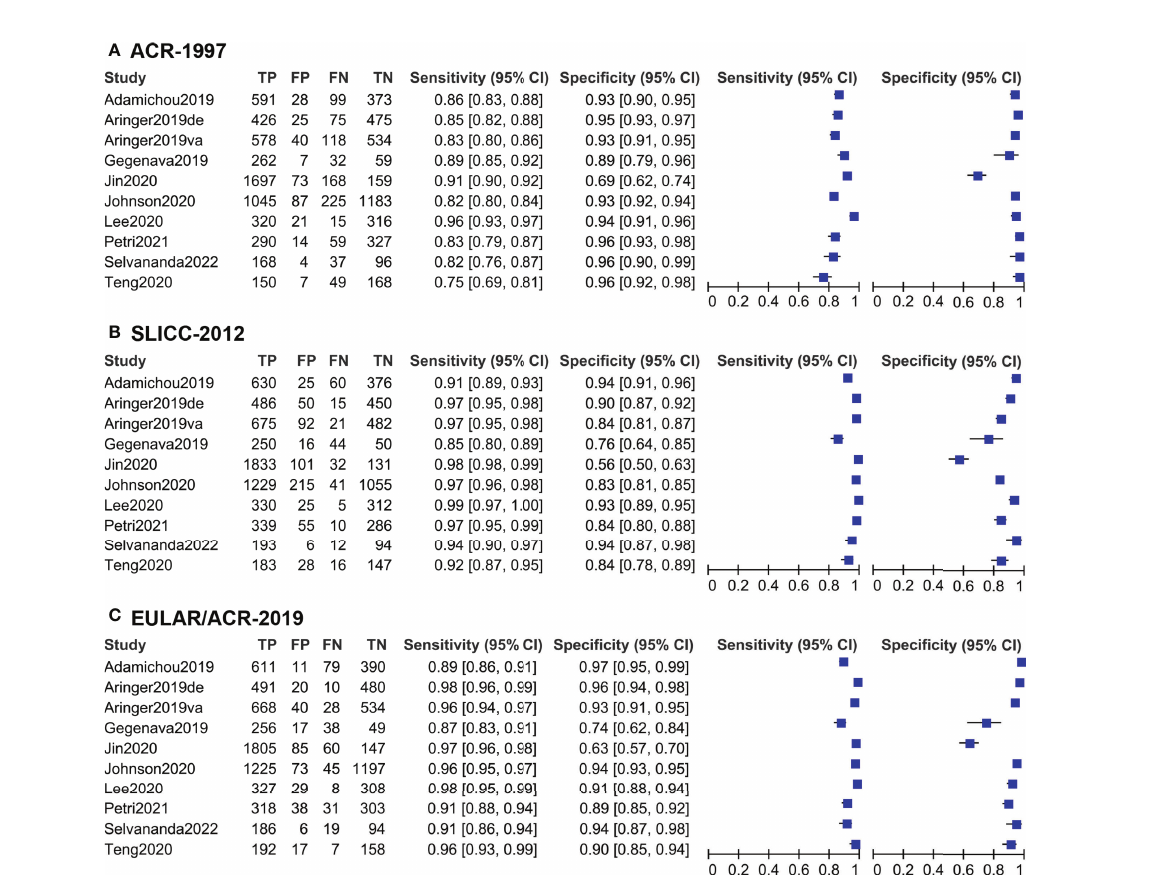
FIGURE 3 The sensitivity and speci fi city of ACR-1997 for each study cohort were shown in part (A) . And the sensitivity and speci fi city of SLICC-2012 and EULAR/ACR-2019 were shown in part (B, C) respectively. Numbers are rounded off to the nearest integer. Expert diagnosis as the reference